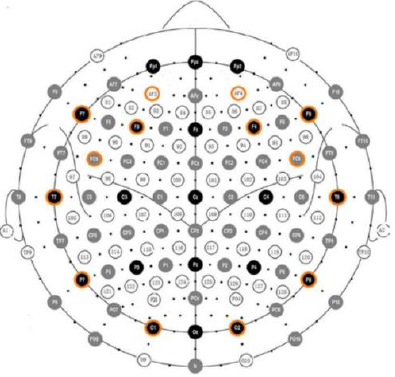
Figure 1. Electrode positions in the Emotiv EPOC (shown in orange) according to the international 10 – 20 system.